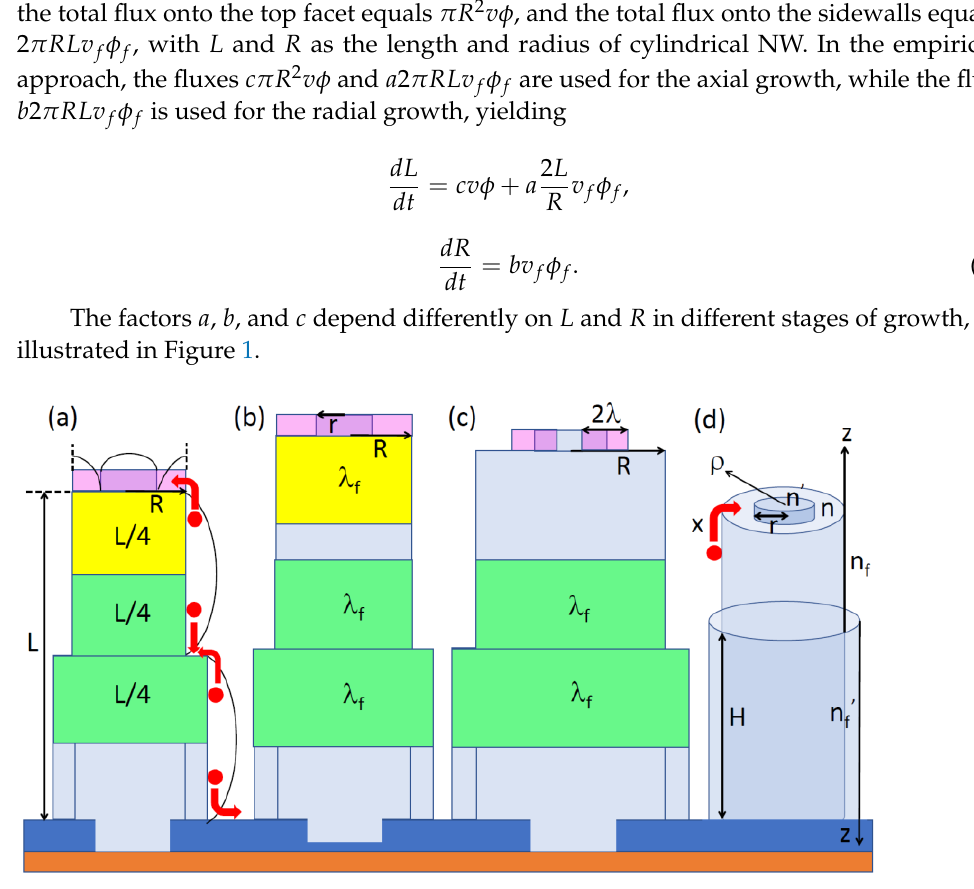
Figure 1. Illustration of (a) stage 1 for short and thin NW, (b) stage 2 for long and thin NW, and (c) stage 3 for long and thick NW. The pink zones show the areas of the top facet from which group III adatoms enter circular island growing on the NW top. The yellow zones show the areas of the side facets contributing to the axial growth by attachment to the island on top. The green zones show the fractions of the side facets from which group III adatoms are collected by the single-step propagating on the NW sidewalls. In stage 1, the NW collects adatoms from the whole top facet and the upper section of the sidewalls of height 𝐿 4⁄ . Radial shell collects adatoms from the height 𝐿 2⁄ . The curved lines show symmetric adatom concentration profiles on the NW sidewalls and at the top. In stage 2, the sidewall collection length is reduced to 𝜆 𝑓 . In stage 3, no sidewall adatom can reach the step growing on top, whereas the top collection area is reduced to 2𝜋𝑟𝜆 . (d) Illustration of cylindrical NW geometry and the four populations of adatoms on top of 2D island ( 𝑛 ′ ), on the top terrace ( 𝑛 ), on top of cylindrical shell around the NW core ( 𝑛 𝑓′ ), and on the terrace 𝑛 𝑓 . 𝑥 denotes the diffusion flux from the NW sidewalls to its top. The 𝜌 and 𝑧 axes show the directions chosen in the corresponding diffusion equations. The red arrows in (a,d) show the directions of the adatom diffusion fluxes.